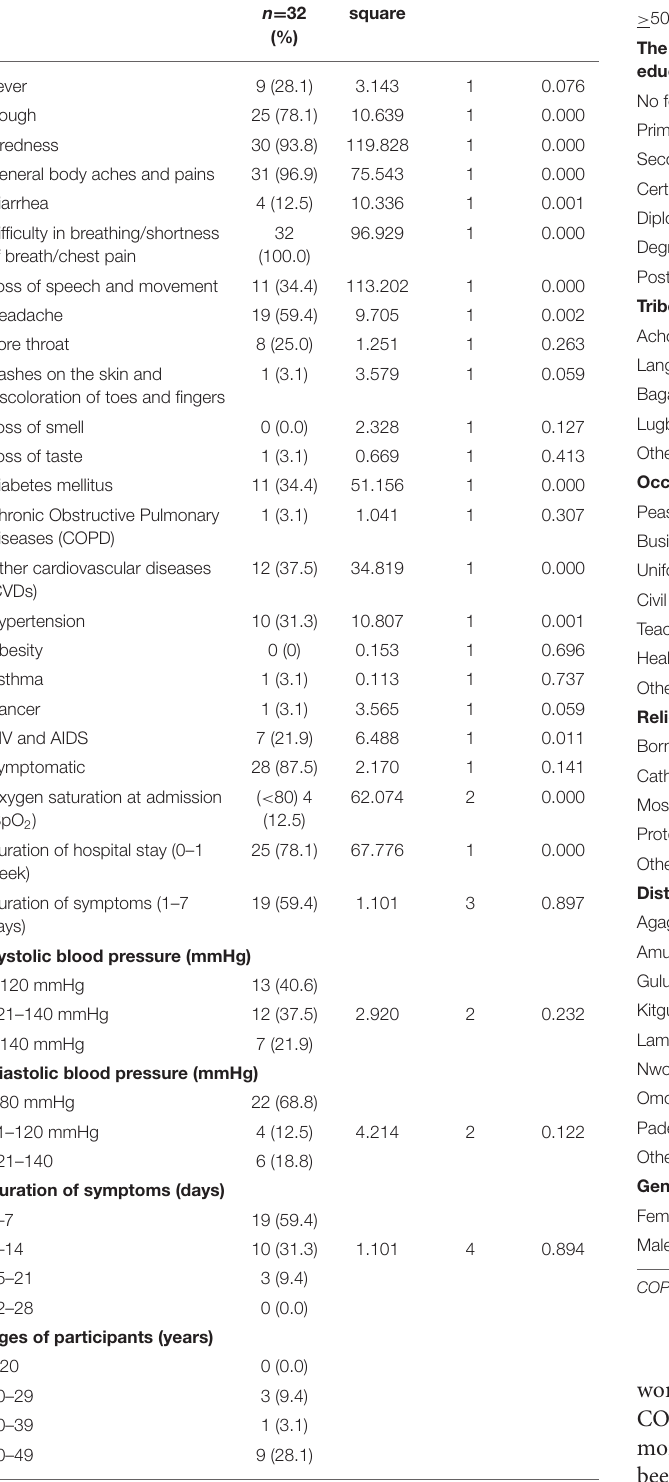
work done over the period in successfully treating over 900 COVID-19 patients in one year and eight months with very low mortality considering the resource scarcity. This could not have been achieved without the dedication and technical expertise of the medical team at the Gulu Regional Referral Hospital